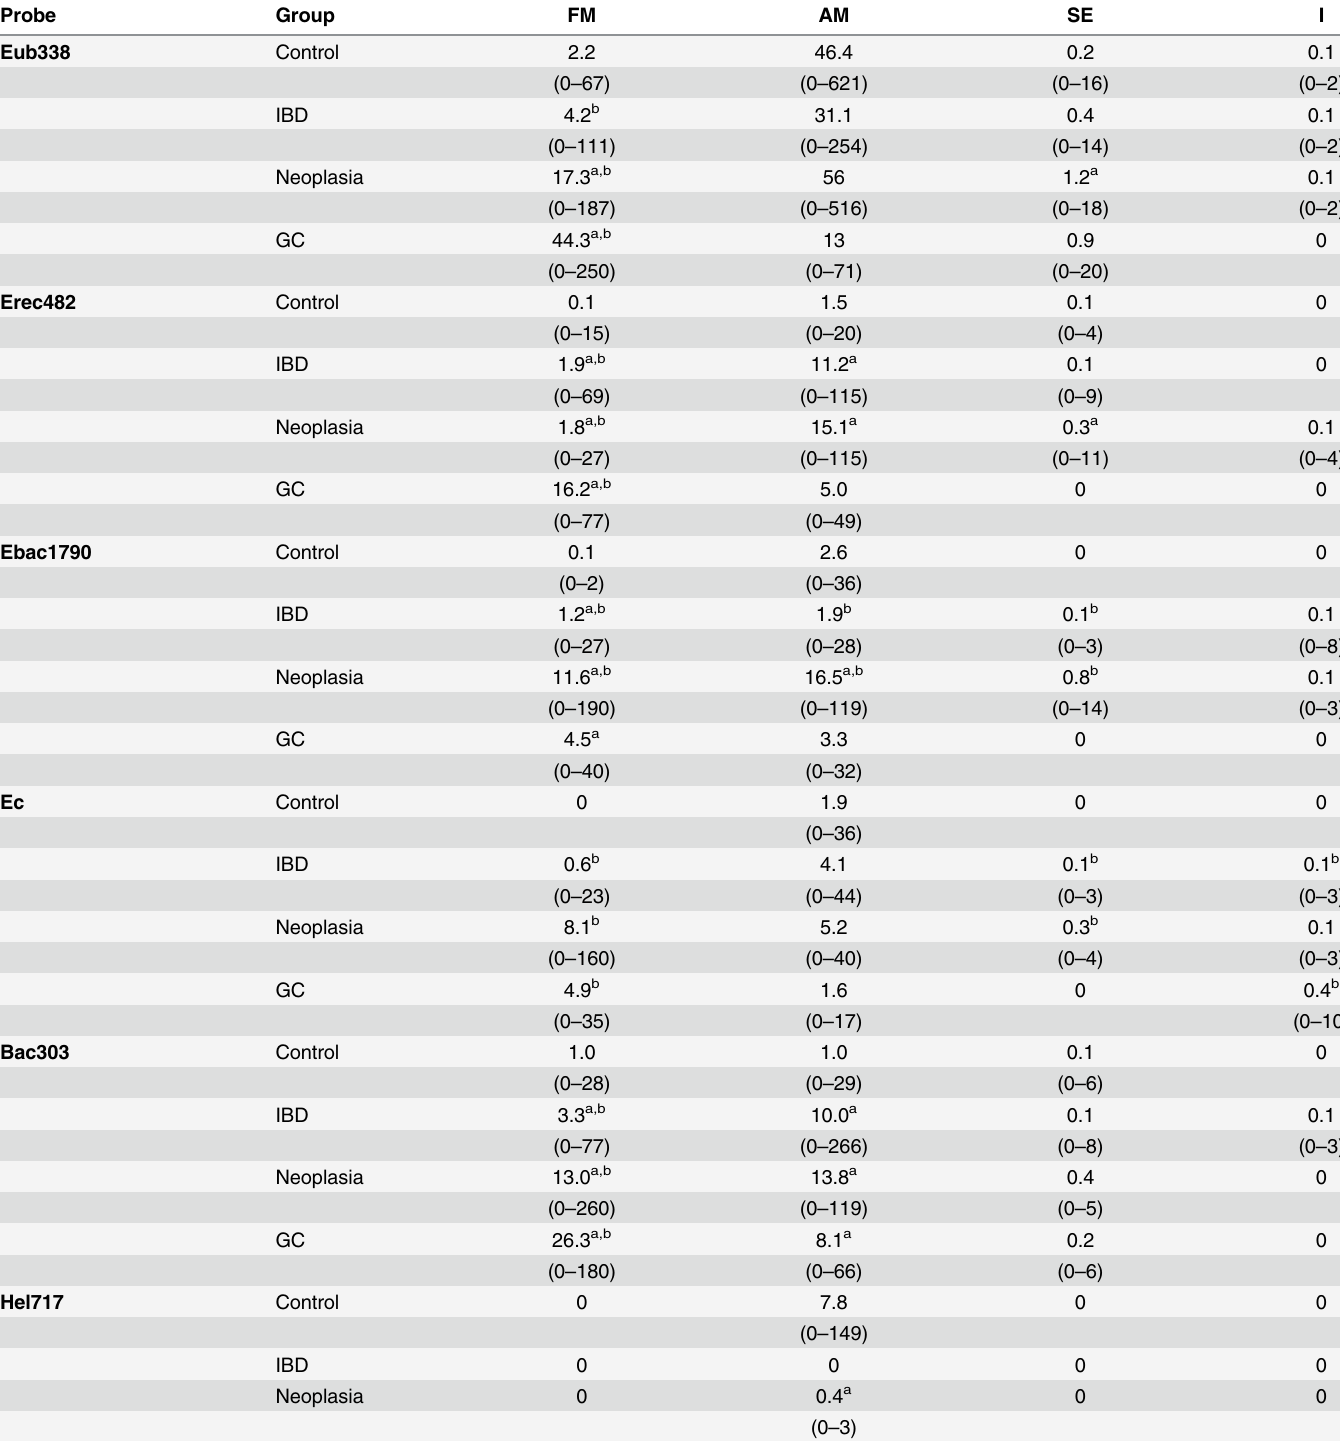
Table 6. Spatial distribution of the number of ileal bacteria based on